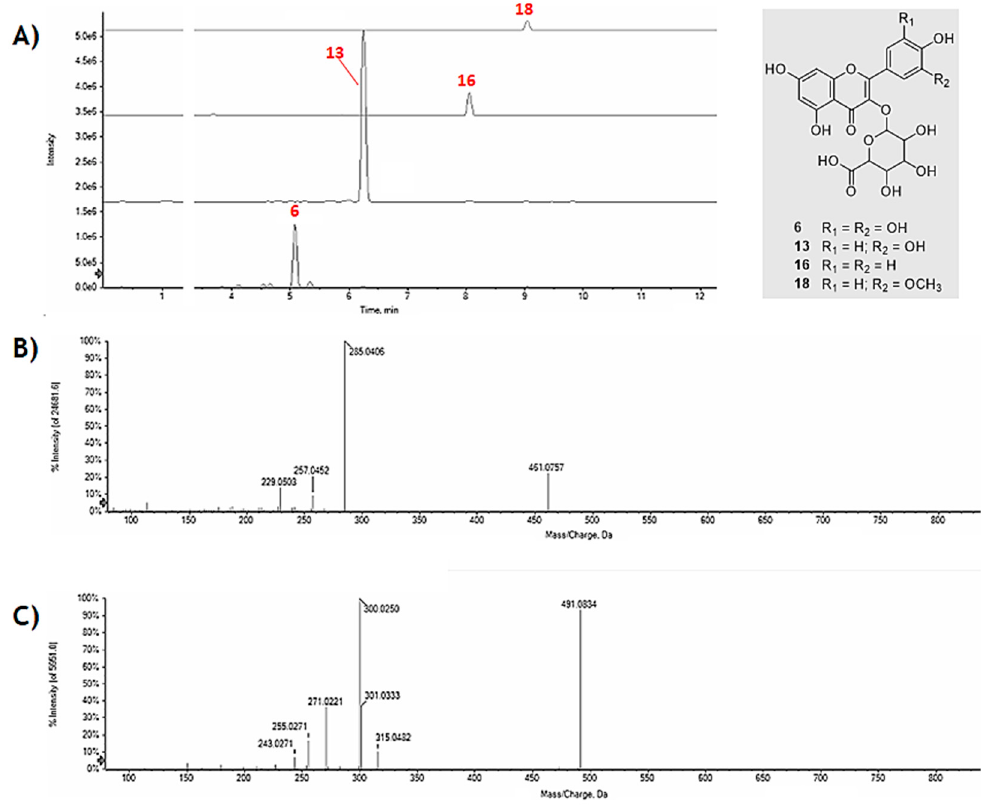
Figure 3. ( A ) Extracted ion chromatograms (XICs) of hexuronyl flavonols, whose structure is depicted in the grey box; TOF-MS 2 spectra of ( B ) 16 and ( C ) 18 .